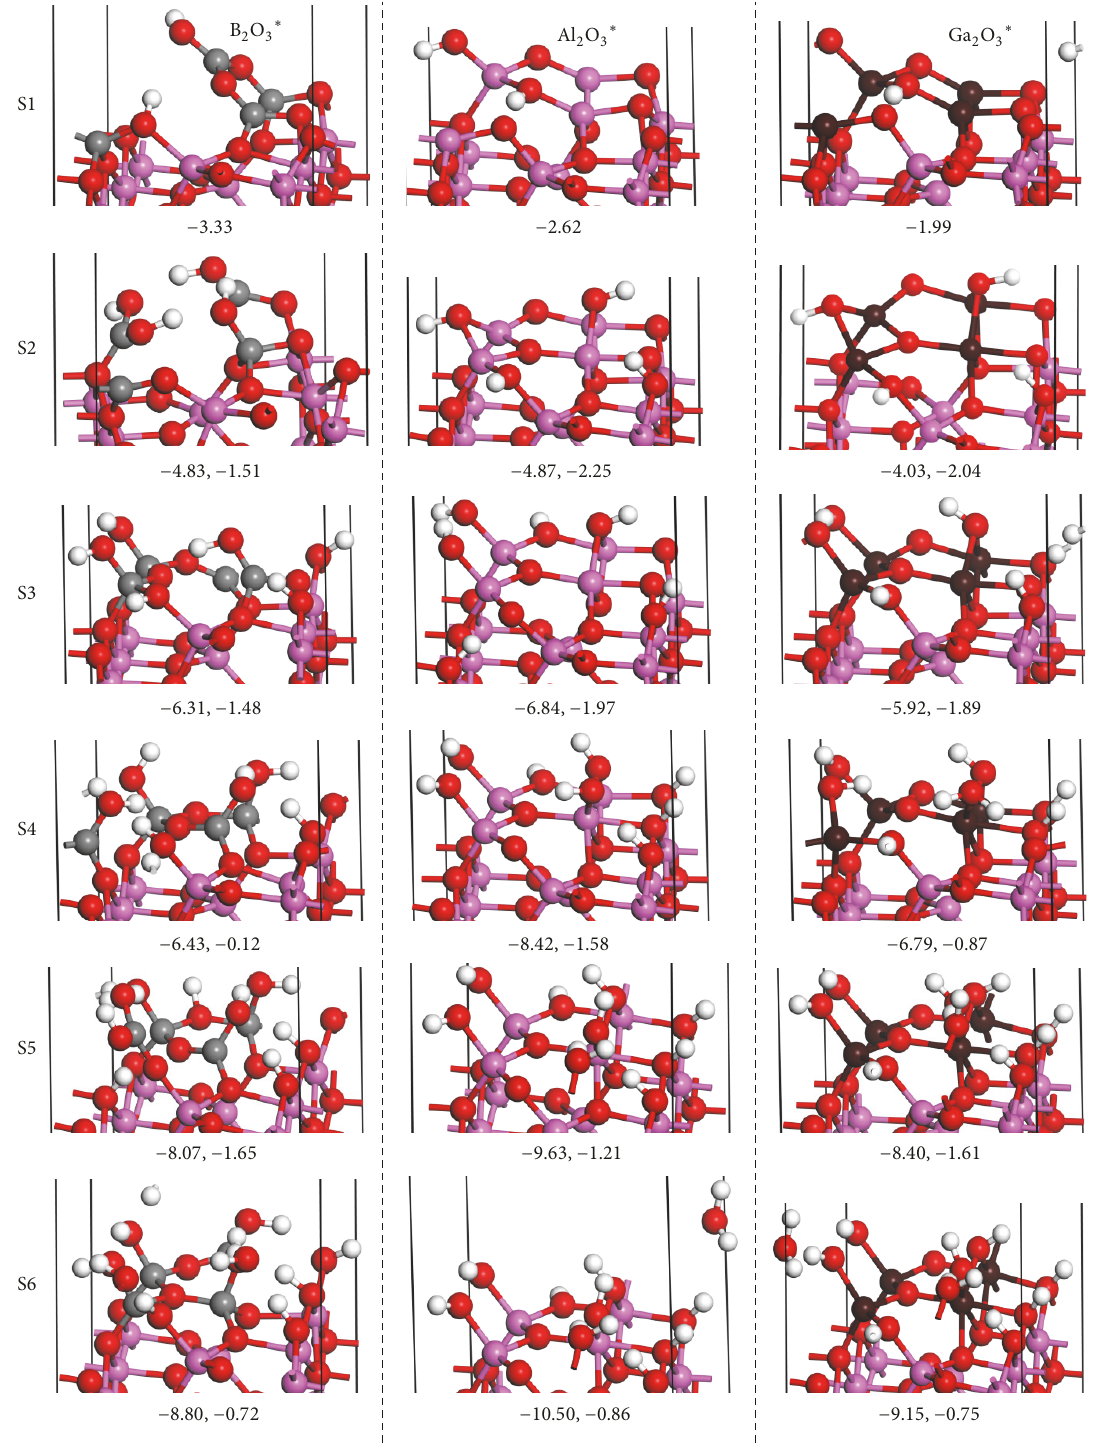
Figure 3: Side views for subsequent water adsorption on B 2 O 3∗ , Al 2 O 3∗ , and Ga 2 O 3∗ surfaces, S 𝑛 ( 𝑛 = 1–6). The total and (subsequent) adsorption energies are given in eV. (B, Al, Ga, O, and H atoms are in gray, rose, dark, red, and white,